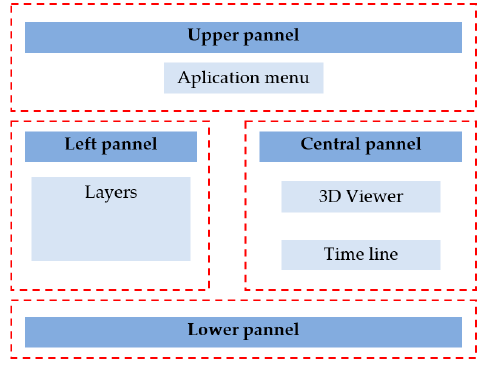
Figure 4. Schematic representation of the architecture used in the developed 4D viewer.